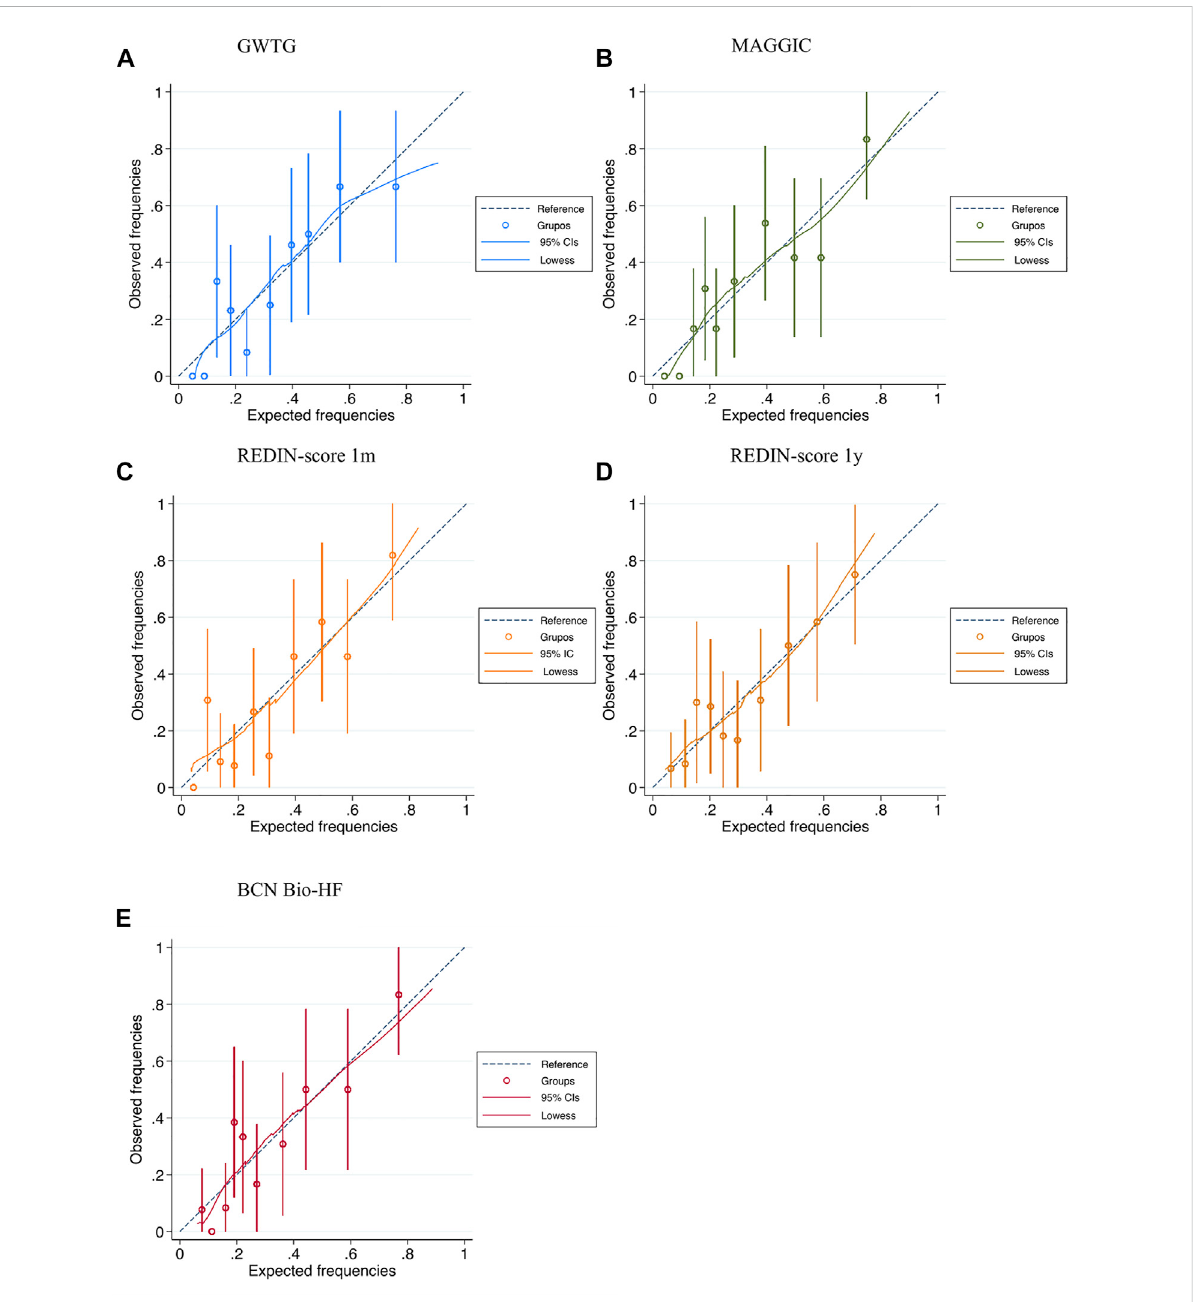
FIGURE 3 Decision curve analysis for predicting the primary composite endpoint. Decision curve analysis illustrates the performance of the model in a range of threshold probabilities, which may of interest to the clinician making the decision. X axis represents the probability threshold for the composite endpoint according to the score. The y axis represents the net bene fi t ([true positives - w x false positives]/total number of patients): positivevaluesindicateanimprovementintheclassi fi cationofpatients,andwisacorrectionfactorfortheprobabilitythreshold.Theupperlimit is0.32 because theincidenceof readmission for HF inLUS-HF was 32%. The diagonal black line assumes that all expected patients werereadmitted, 32% at 6 months. The coloured lines represent the result of applying the different scores. Adding B-lines provided a net bene fi t due to better classi fi cation of the patients for probabilities below 70% in GWTG and BCN Bio-HF scores (A,E) . When B-lines were incorporated to MAGGIC score (B) ,anetbene fi twasobtainedduetobetterclassi fi cationofthepatientsforprobabilitiesbetween0and80%.RegardingREDIN-score1 yearand1m, a net bene fi t was obtained in all probability spectrum when using LUS data (C,D)